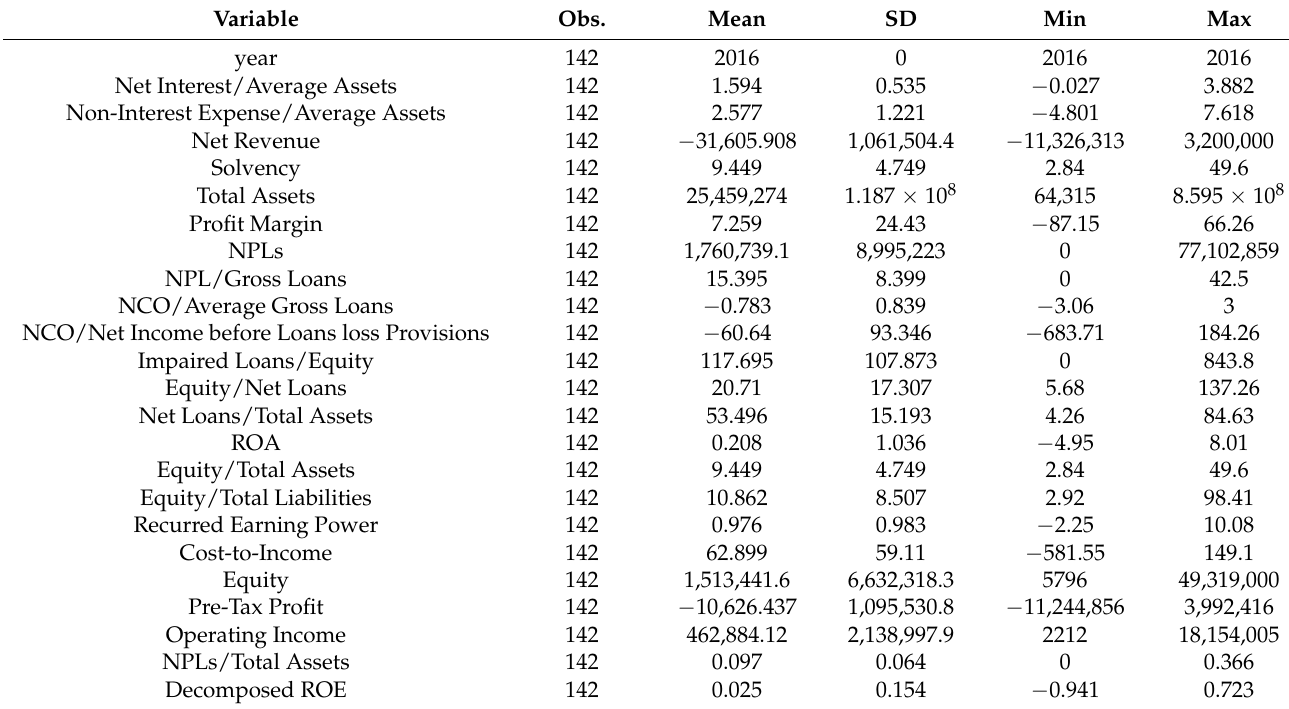
Table A6. Descriptive statistics for the 142 Italian banks for the year